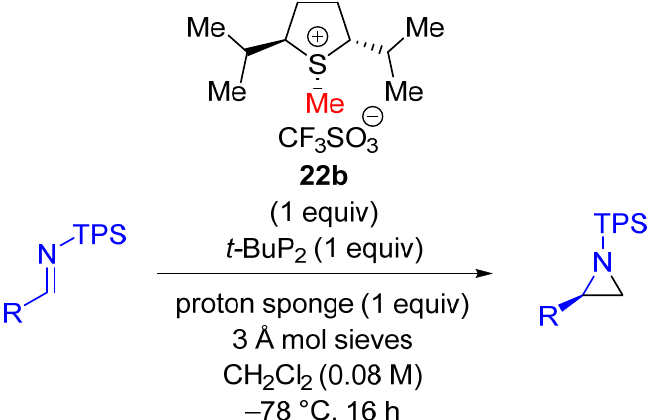
Table 6. Scope of Connon’s enantioselective synthesis of terminal aziridines (Scheme 25).